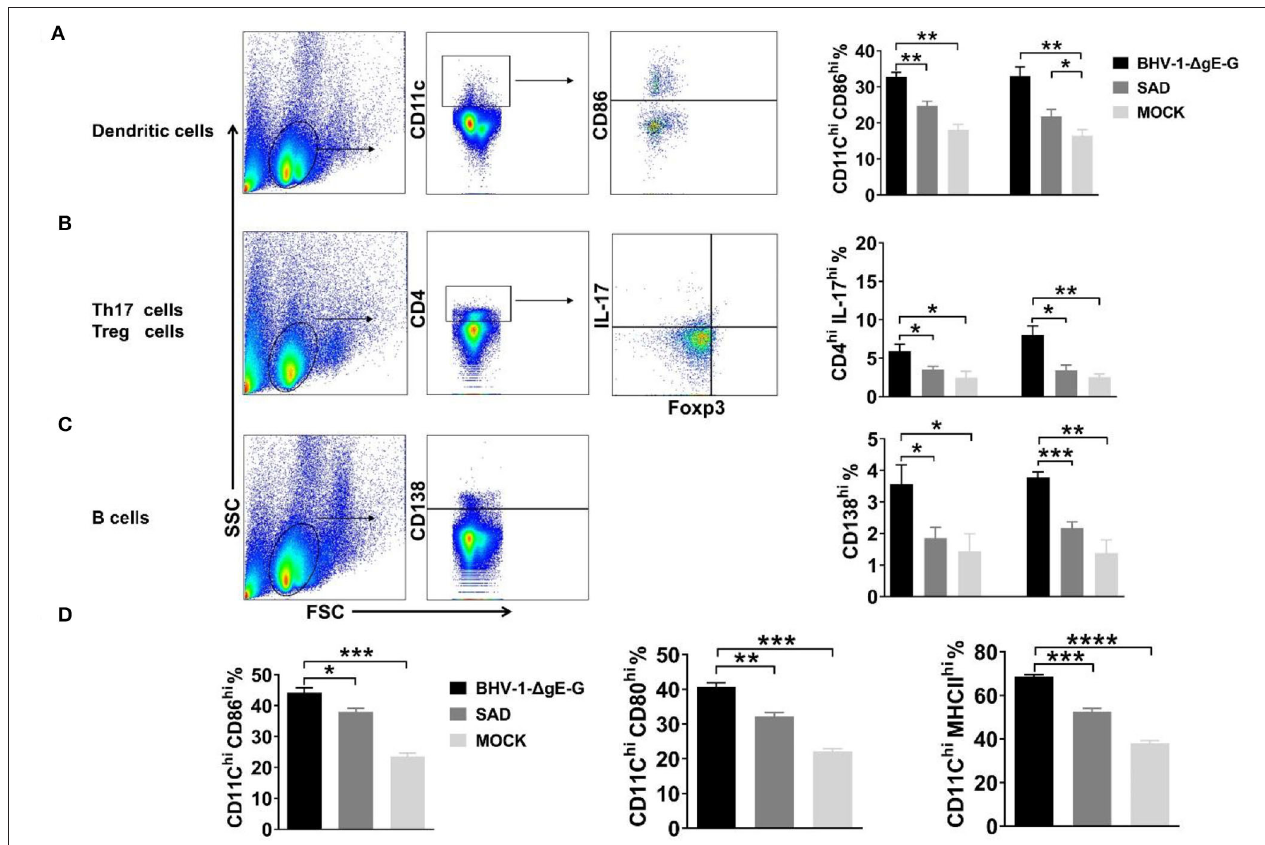
FIGURE 3 | BHV-1- 1 gE-G induces early activation of immune cells. (A–C) Flow cytometric analysis of activation status of DCs, Th 17 cells, and B cells in mice inguinal lymph nodes which were immunized with the indicated virus via the IM route. (D) Flow cytometric analysis of CD11c, CD86, or MHCII expression level of DCs infected with 0.1 MOI of indicated virus at 48 hpi. Significance was assessed using Student’s t -test. * P ≤ 0.05; ** P ≤ 0.01; *** P ≤ 0.001; **** P ≤ 0.0001.